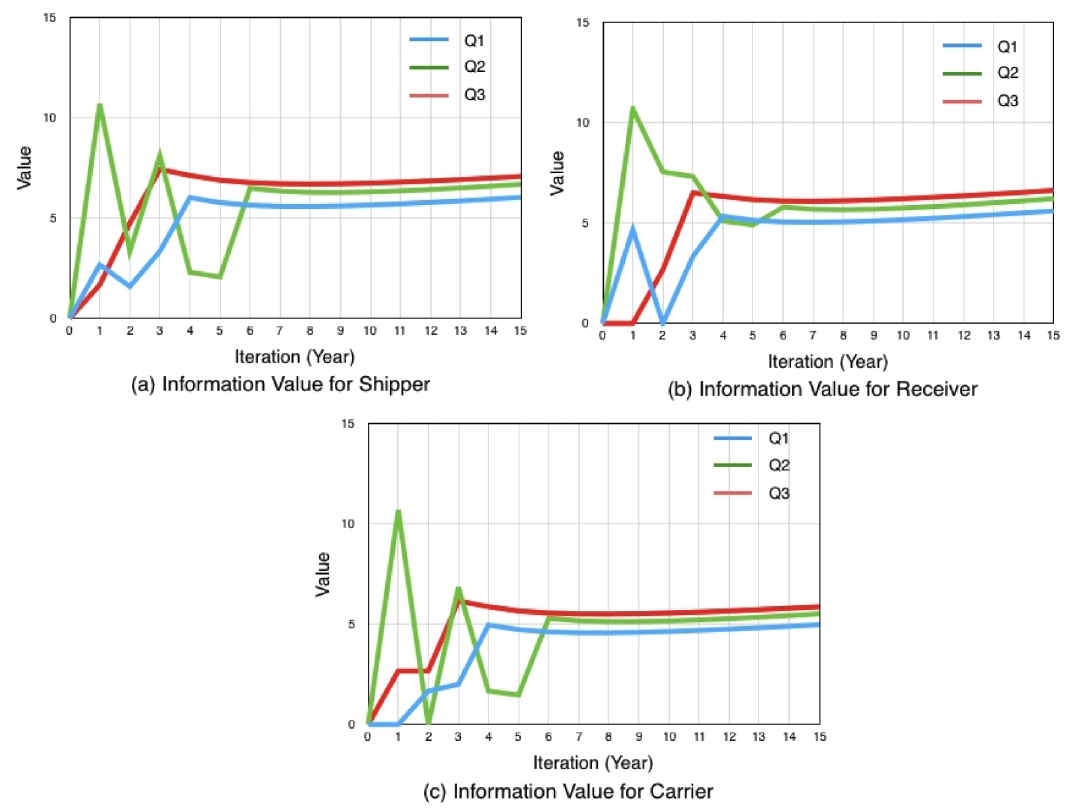
Figure 3. Information Value of the Agents in Formation Stage: (a) Shipper, (b) Receiver, and (c)